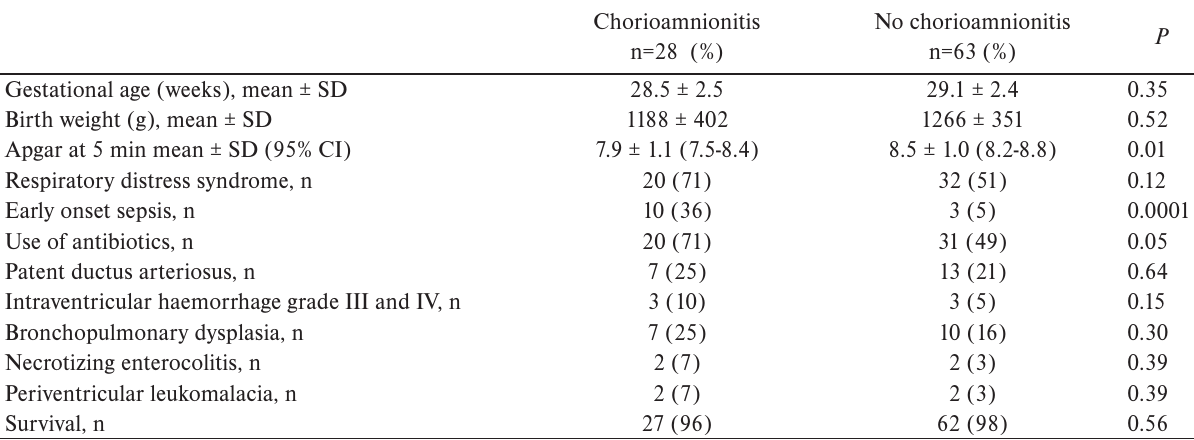
Table 2. Neonatal outcome in chorioamnionitis positive and chorioamnionitis negative groups. Statistically significant difference P <0.05 (expressed between “no chorioamnionitis“ and “chorioamnionitis“